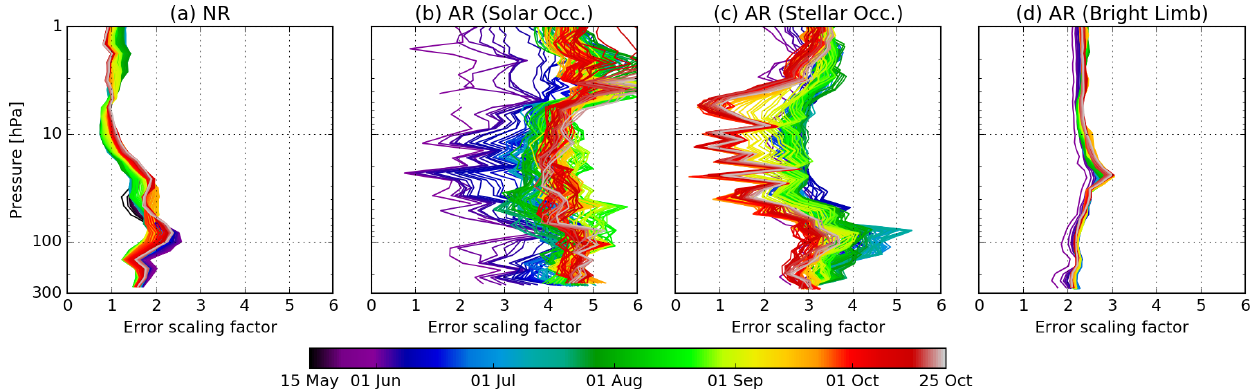
Figure 11. Profiles of daily error scaling factors estimated using the Desroziers method for MLS data assimilated in NR ( a ) and ALTIUS data from solar occultations (b) , stellar occultations (c) and bright limb (d) assimilated in AR.